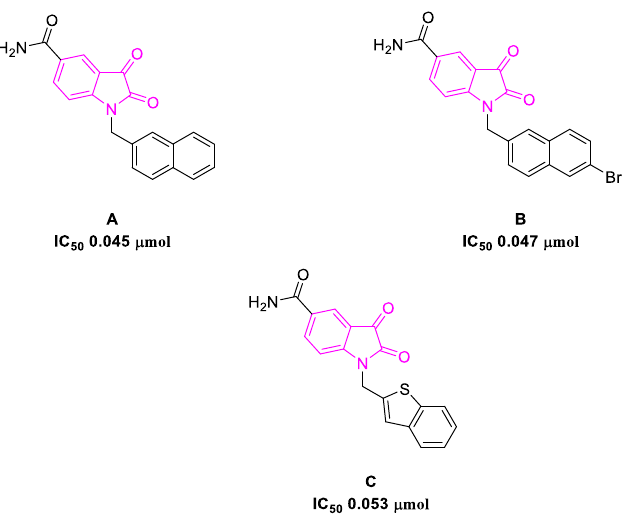
Figure 7. Lead compounds in Lai’s